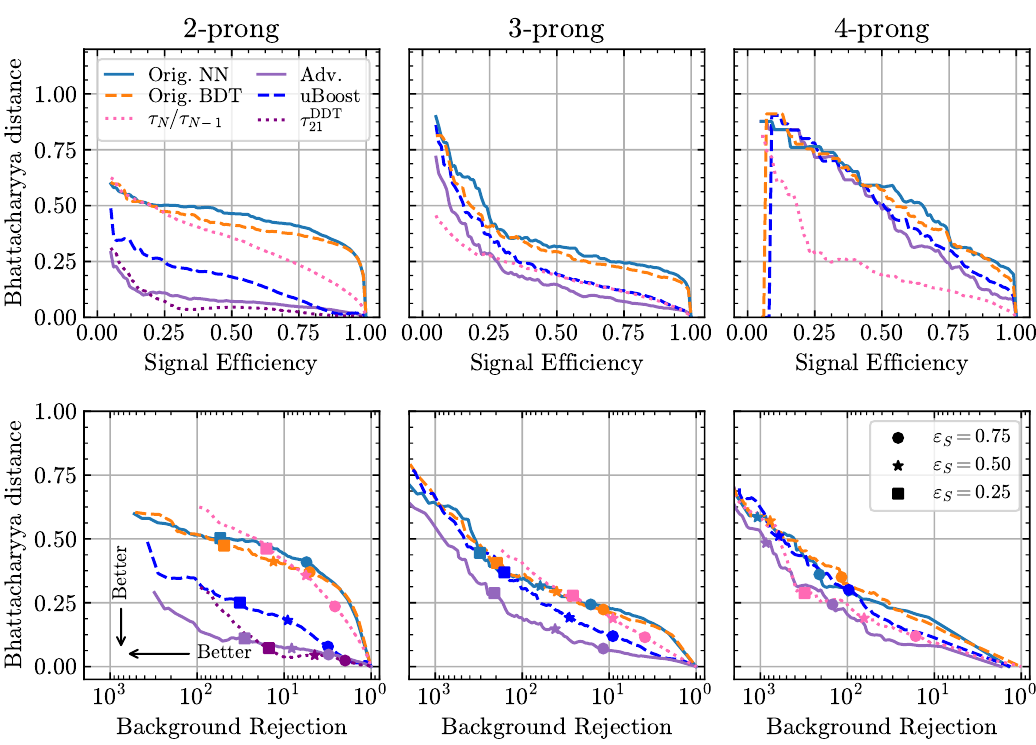
Figure 12: The Bhattacharyya distance for the QCD background distributions com- pared to the original distributions. The distance is defined in Eq. (9), and a larger distance represents more sculpting—lower on the plot is better. The upper and lower rows plot the distance as a function of signal efficiency or background rejection, re- spectively. τ DDT